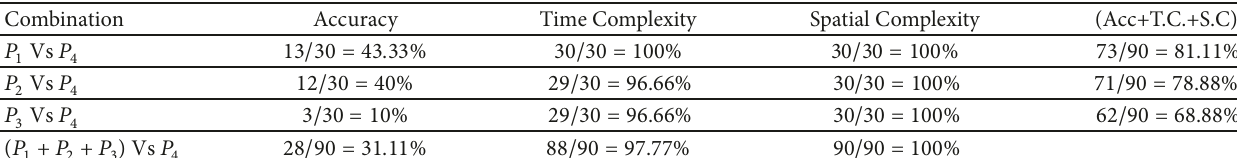
Table 5: Statistically significant differences in each dimension for all HPO across all 𝐷 𝑖 of RF for each comparison between 𝑃 𝑗 (𝐷 𝑖 ) and 𝑃 4 (𝐷 𝑖 ) and the total (%).